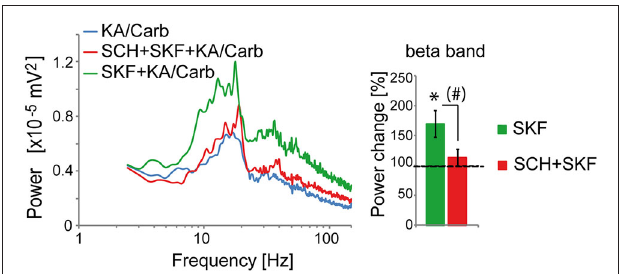
FIGURE 3 | Activation of D1R enhances the power of high-frequency oscillations in the ACC . The enhancement of the power of the oscillations that is induced by the D1R agonist (SKF-38393, SKF, 0.8 µ M) (one-tailed, P = 0.0085, n = 10) is prevented by the D1R antagonist (SCH23390, SCH, 5 µ M). SCH reduces the power increase induced by SKF (one-tailed, P = 0.02) and the power is not significantly higher in the SKF + SCH compared to the no D1R modulator condition (one-tailed, P > 0.05). Left : power spectra of recordings (mean of pooled data). Right : Change in the power of the oscillations induced by SKF and by SKF + SCH, respectively (100% corresponds to the power of oscillations elicited by KA/Carb in absence of dopaminergic modulators). * P < 0.05, significantly different from the KA/Carb condition after Bonferroni correction; # P < 0.05, but no more significantly different between the two conditions after Bonferroni correction. Bars, sem.